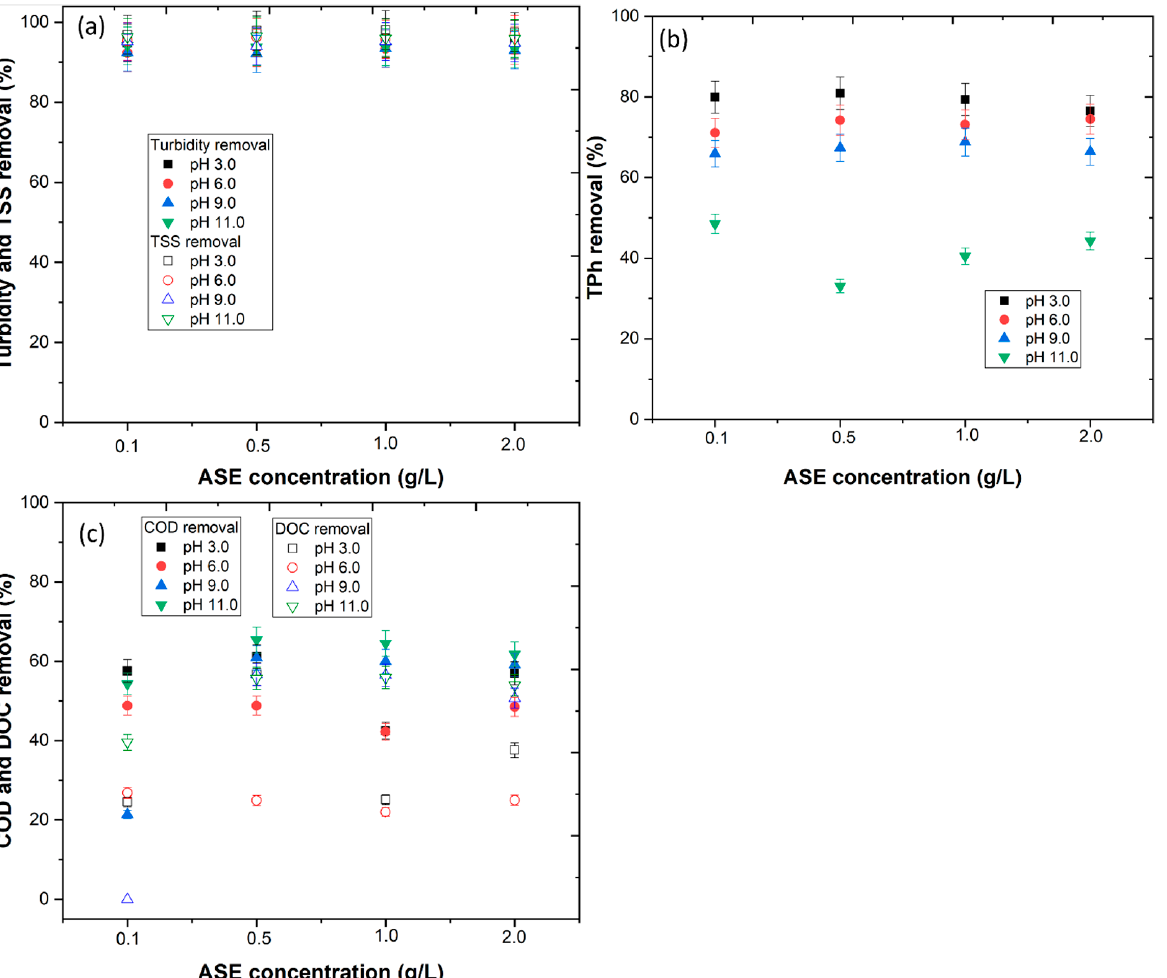
Figure 2. Effect of ASE concentration (g/L) vs. pH in ( a ) turbidity and TSS removal, ( b ) TPh removal, and ( c ) COD and DOC removal from winery wastewater. Operational conditions: fast mix (rpm/min) = 150/3, slow mix (rpm/min) = 20/20, sedimentation time of 4 h.